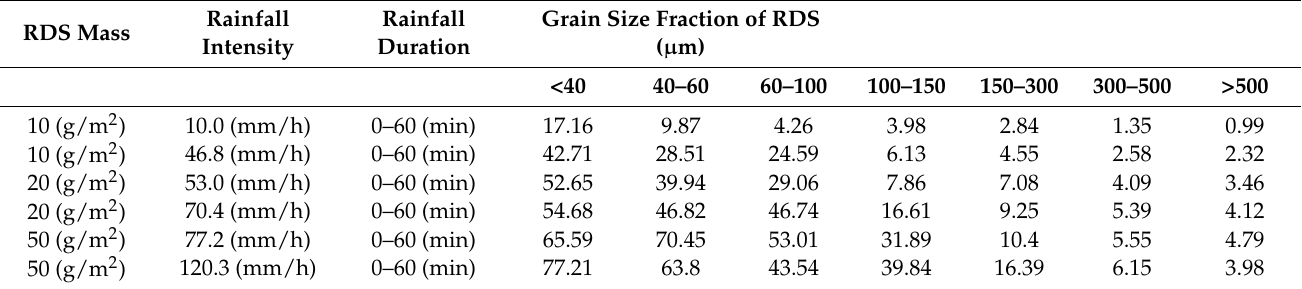
Table 4. The wash-off (%) of RDS on different grain size fraction at different levels of RDS by rainfall